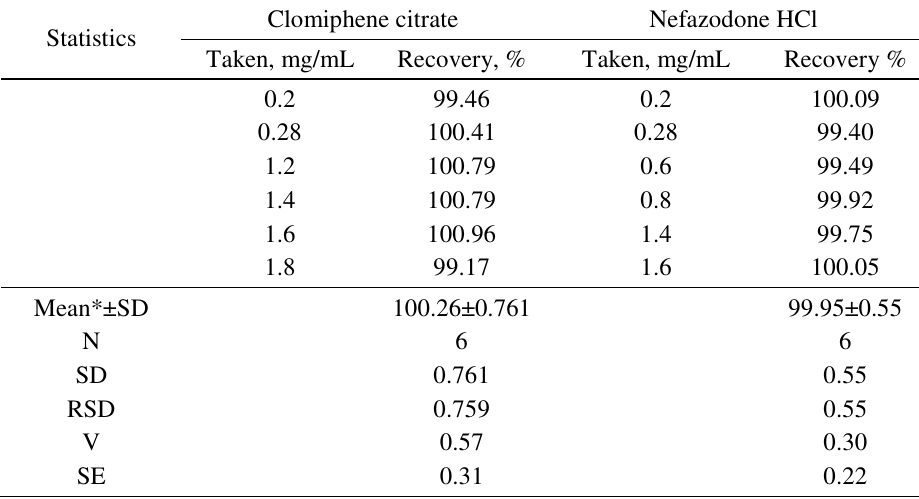
Table 2. Determination of clomiphene citrate and nefazodone HCl through complexation with ammonium